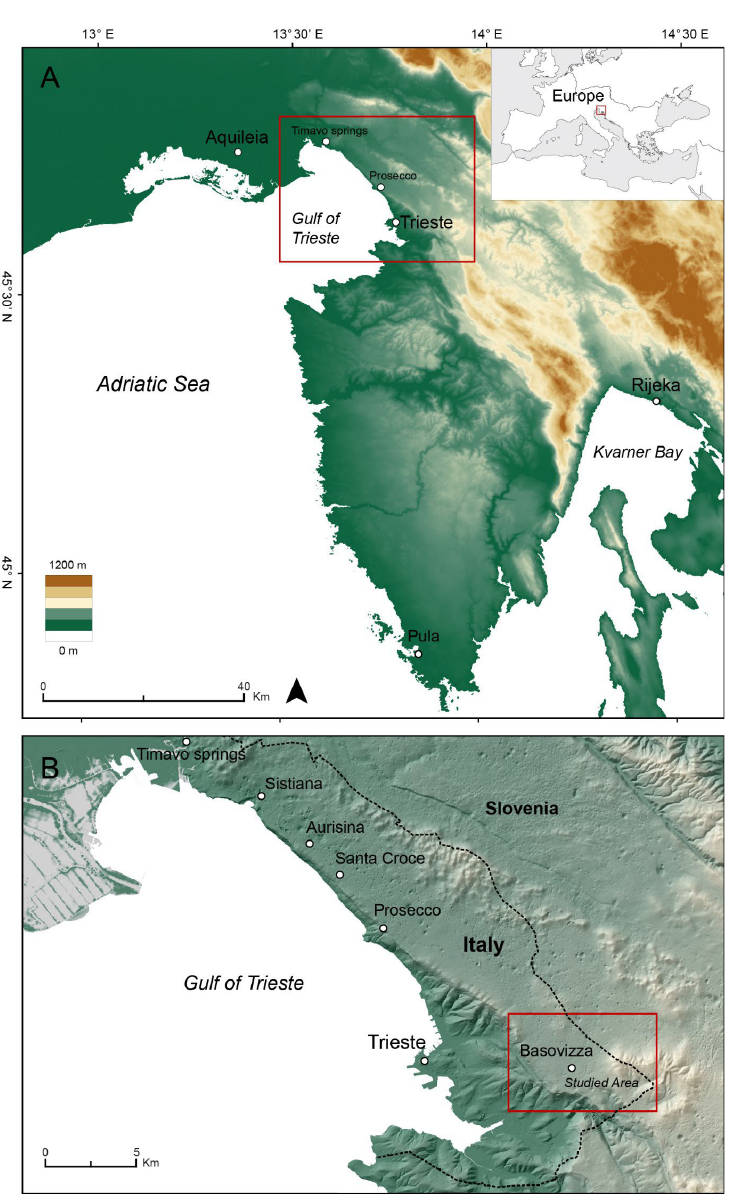
Figure 1. Position of the investigated area (A) and main localities mentioned (B) in the paper. Figure modified from [9].